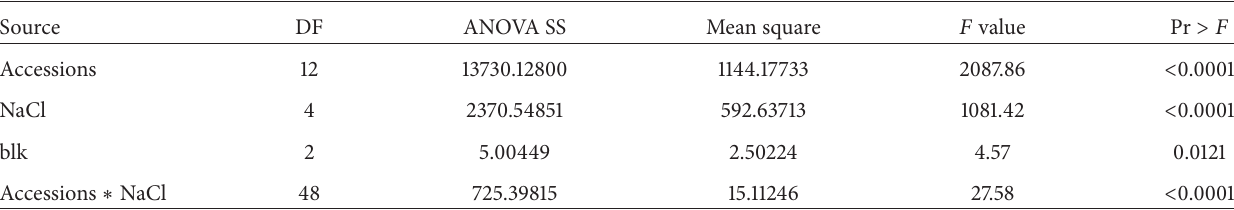
Table 3: ANOVA table for plant height with salinity